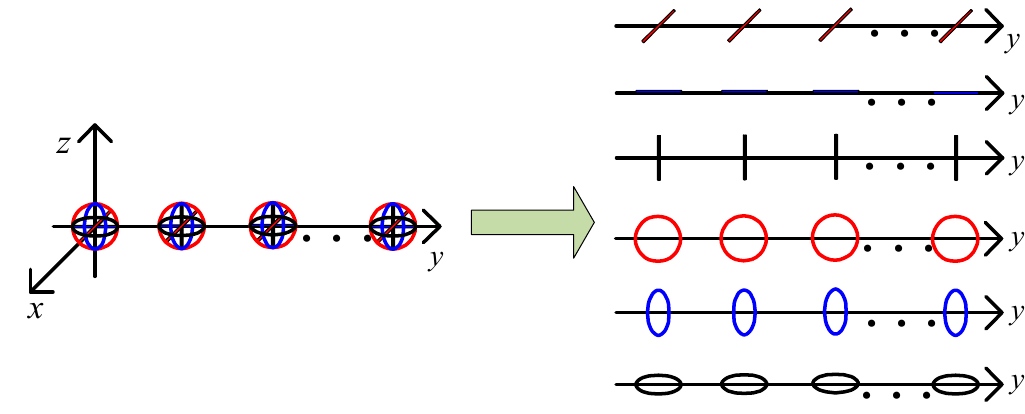
Figure 2. Six spatially identical subarrays offered by EMVSs array.